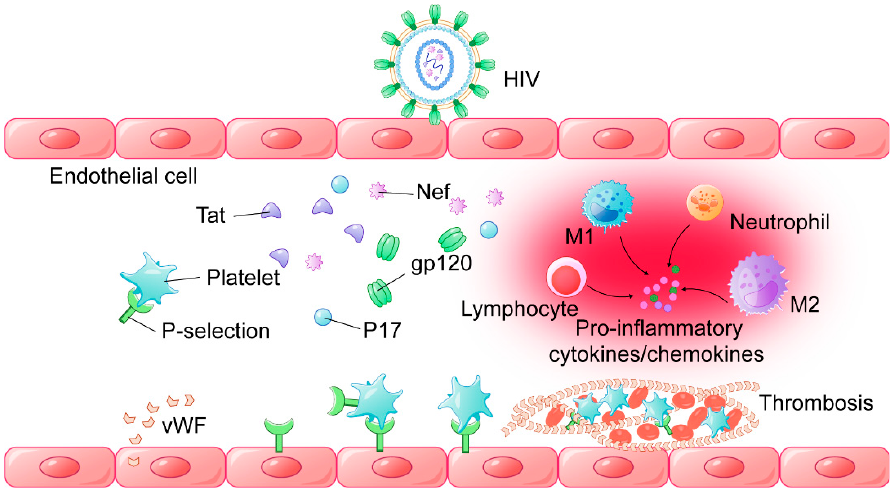
Figure 2. Mechanisms of endothelial activation in the condition of HIV infection. HIV-1-encoded proteins (Tat, Nef, gp120, P17) contribute to the synthesis and release of different cytokines/chemokines from platelet activation (connected with p-selectin), monocytes M1 and M2, neutrophils, and lymphocytes, driving inflammation activation and adhesion of vWF with platelets in the tube wall by linear distribution, which can trap leukocytes and erythrocytes, promoting thrombosis formation.